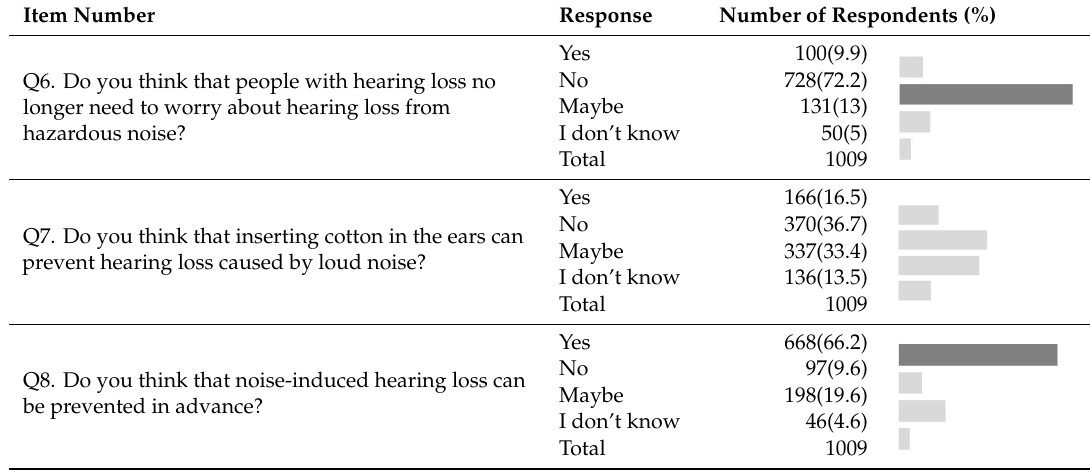
Table A2. Knowledge of factors triggering hearing loss and hearing loss